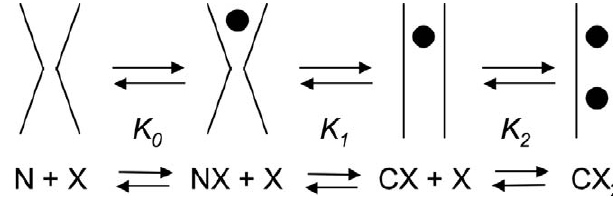
The four-state ion-binding scheme is shown, from left to right: non- conductive conformation without an ion (N), non-conductive conforma- tion with a single ion (NX), conductive conformation with a single ion (CX), and conductive conformation with two ions (CX 2 ) with equilibrium constants K 0 , K 1 , and K 2 . doi:10.1371/journal.pbio.0050121.g007 PLoS Biology |